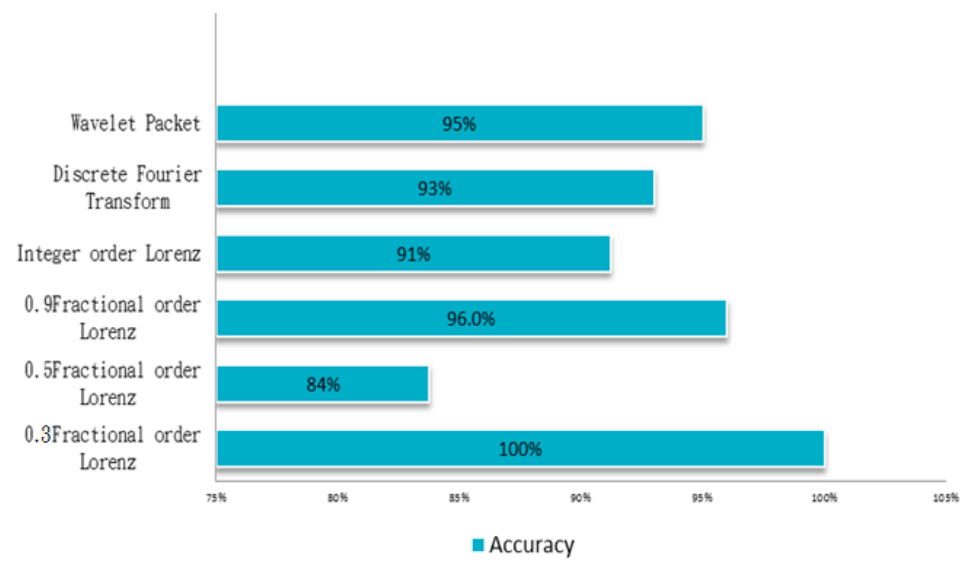
Figure 11. The diagnostic accuracy obtained with each different method.